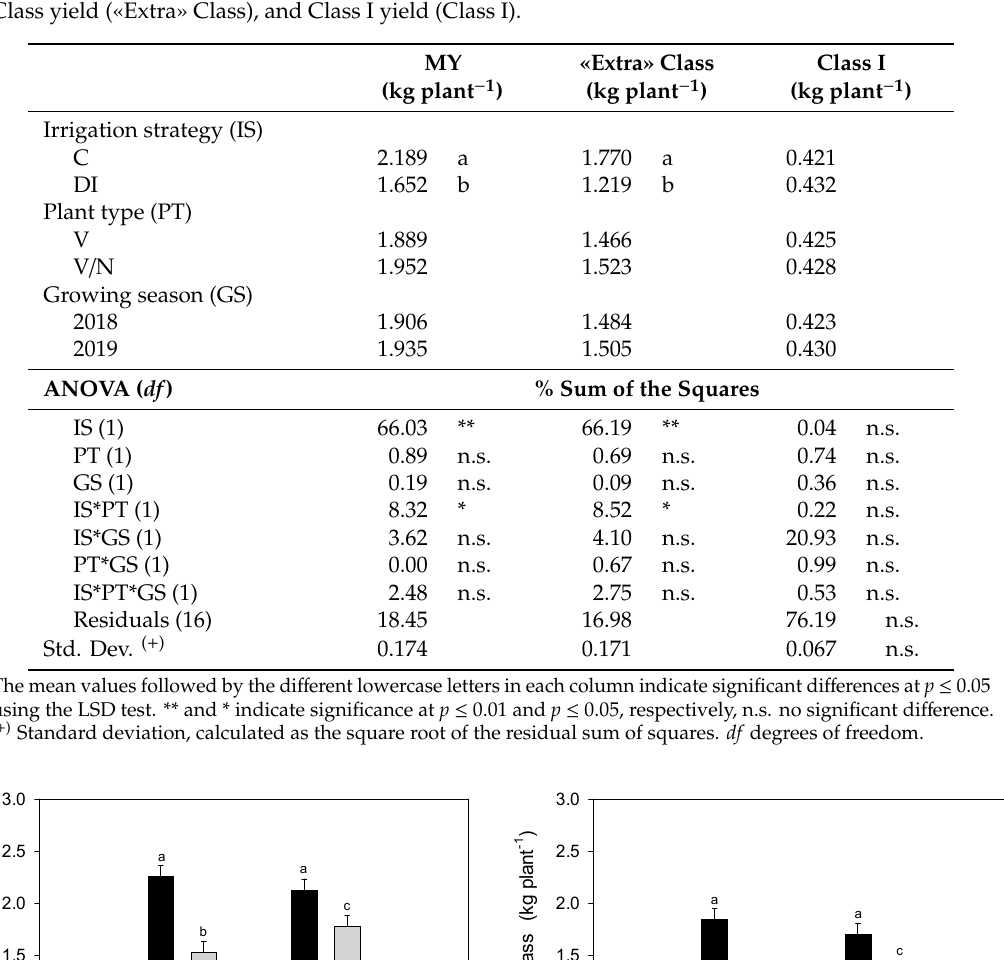
Table 4. E ff ect of irrigation strategy, plant type, and growing season on marketable yield (MY), «Extra» Class yield («Extra» Class), and Class I yield (Class I).